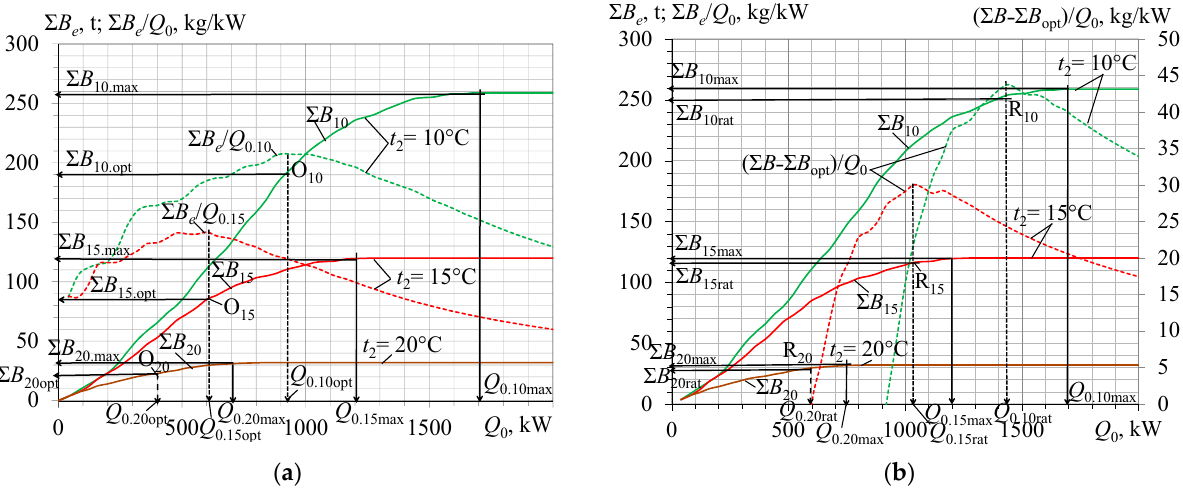
Figure 1. Annual fuel reduction Σ B e and its relative values Σ B e / Q 0 referred to design cooling capacity Q 0 over the whole range of Σ B e ( a ) and values Σ ( B e − B e . opt )/ Q 0 beyond the optimum values of Σ B e . opt and Q 0.opt ( b ) for cooling ambient air to t a 2 = 10, 15, and 20 °C. A maximum rate of annual fuel reduction Σ B e increment Σ B e / Q 0 for t a 2 = 10 ◦